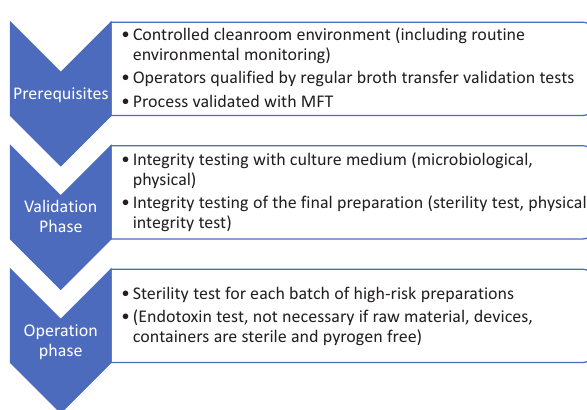
Figure 1: Summary of the strategy in case of batch production from the same initial bulk admixture for